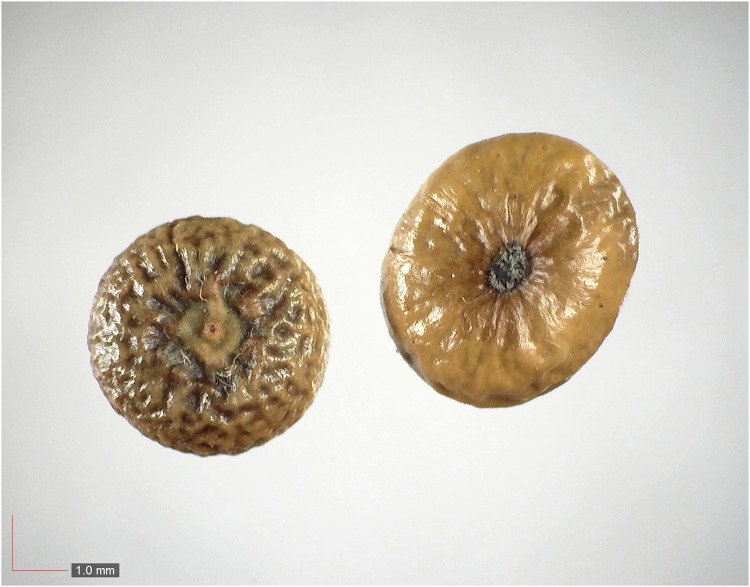
Unidentified 7.Table 2.